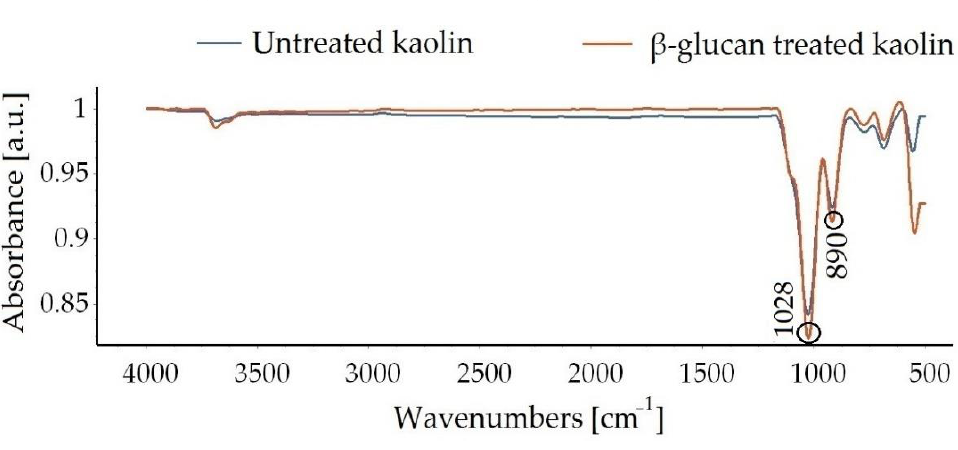
Figure 7. SEM Micrographs. ( a ) Kaolin clay; ( b ) β -glucan-treated kaolin clay.